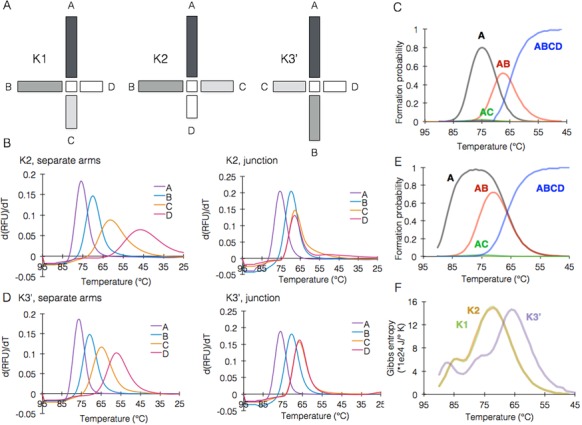
Arm position order affects assembly route and efficiency. (A) schematic representations of K1 and its two reshuffled variants K2 and K3’. (B) fluorescence analysis of the formation of K2 in separate arms (left) versus complete junction (right). (C) NUPACK simulation of the formation sequence of K2. (D) Fluorescence analysis of the formation of K3’ in separate arms (left) versus complete junction (right). (E) NUPACK simulation of the formation sequence of K3’. (F) Simulated entropic landscapes of the formation process of K1, K2, and K3’ showing the similarity between K1 and K2, and variation of K3’.